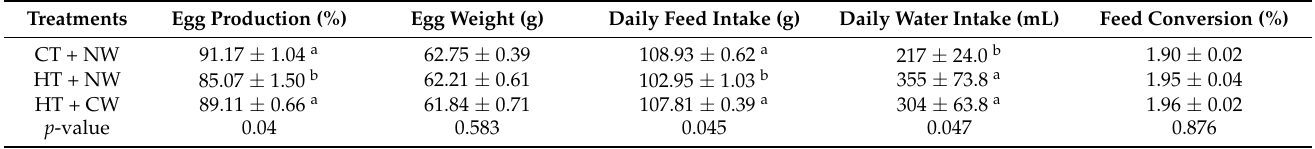
Table 3. The effect of cold drinking water on the performance of laying hens after heat stress exposure.